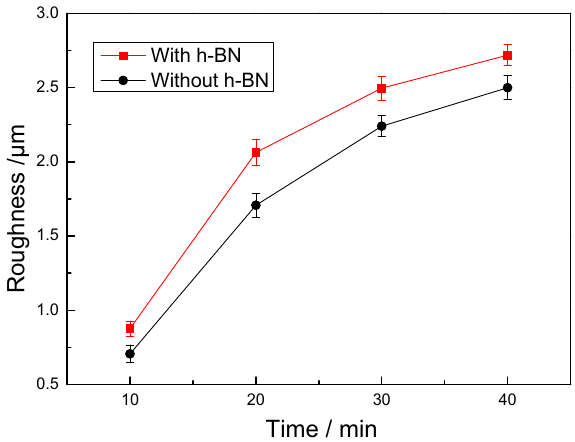
Figure 4. Surface roughness of the coatings at different oxidation time.